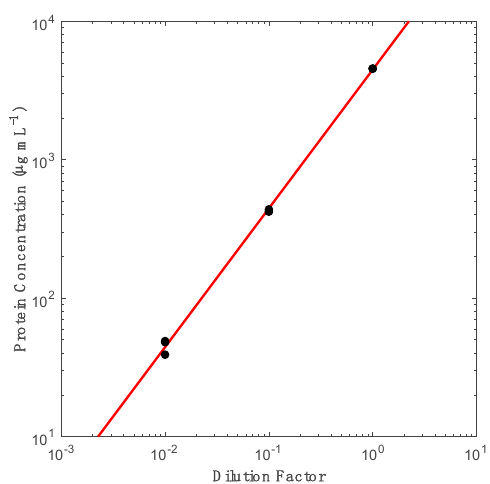
Figure 1. NanoDrop protein concentration approximation using serially diluted fetal bovine serum (FBS). Regression was performed with data from serially diluted FBS, with three measurements shown per dilution.